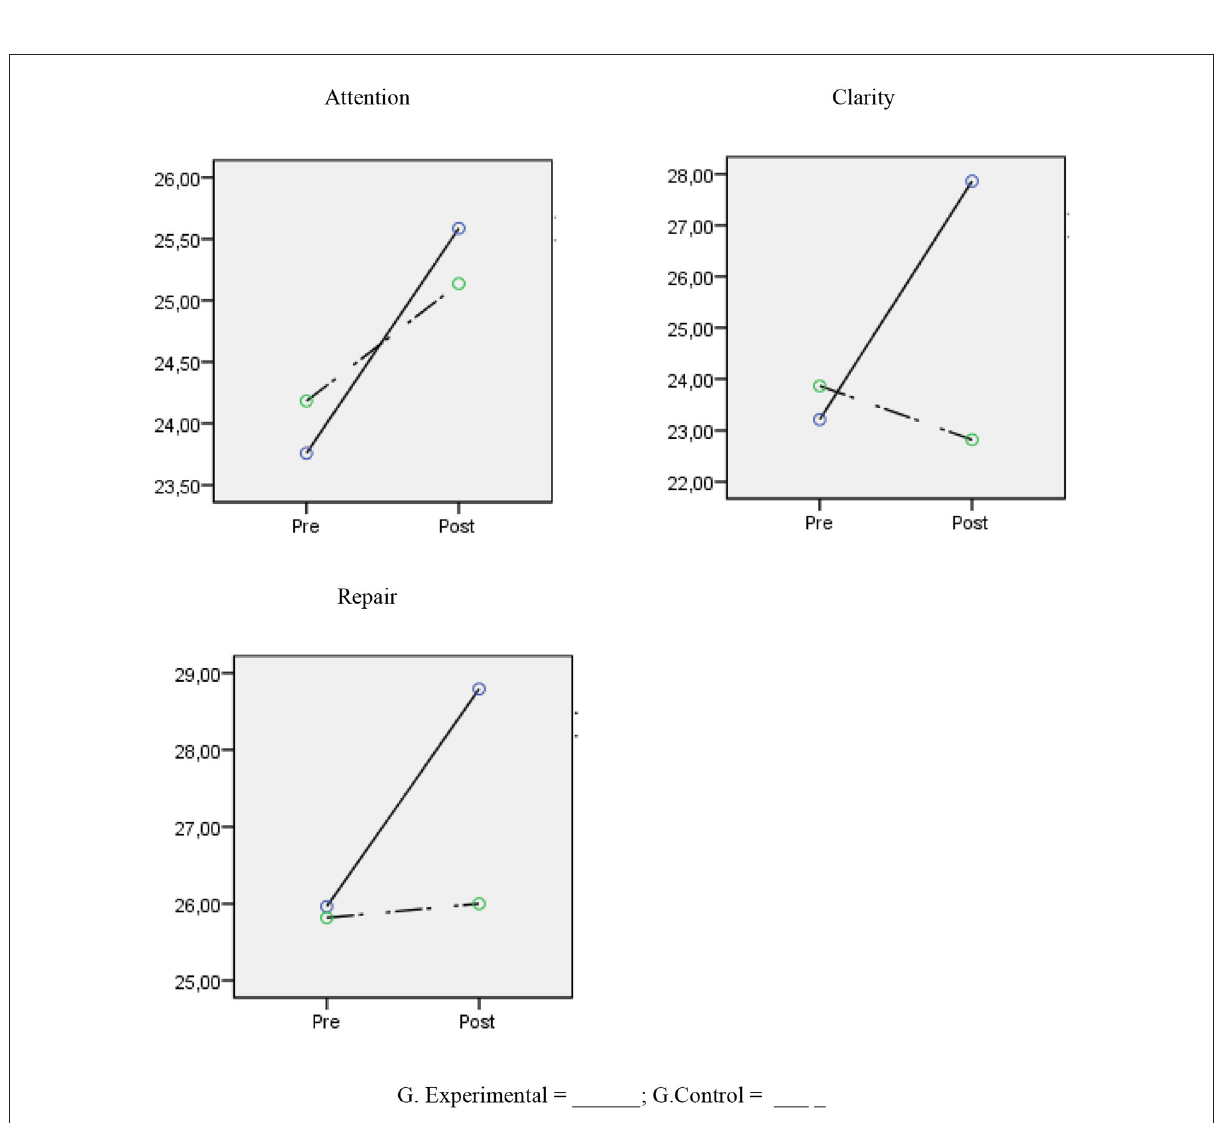
FIGURE2 Change in emotional intelligence scores between experimental and control